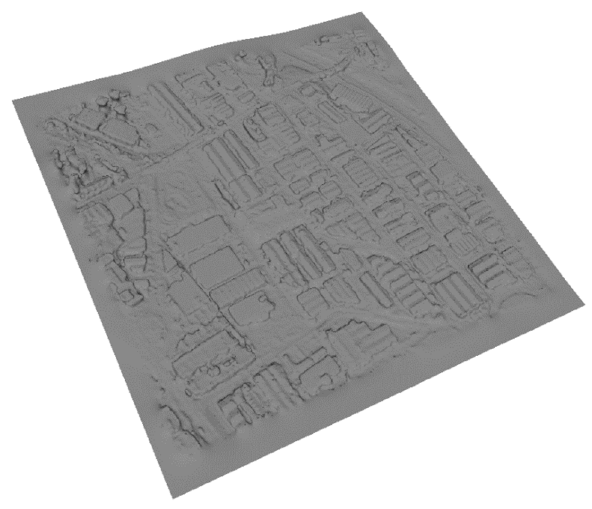
Figure 11. 3D mesh model of the test area.